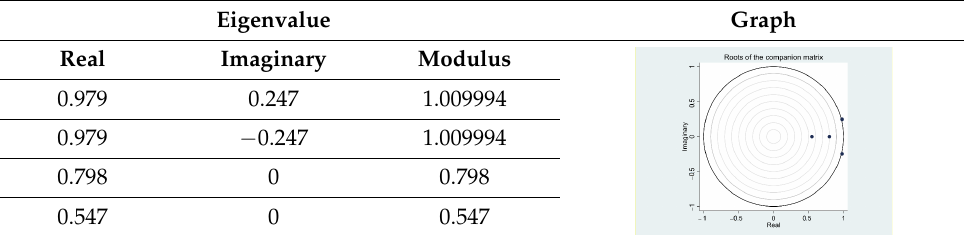
Table 6. Eigenvalue stability test.